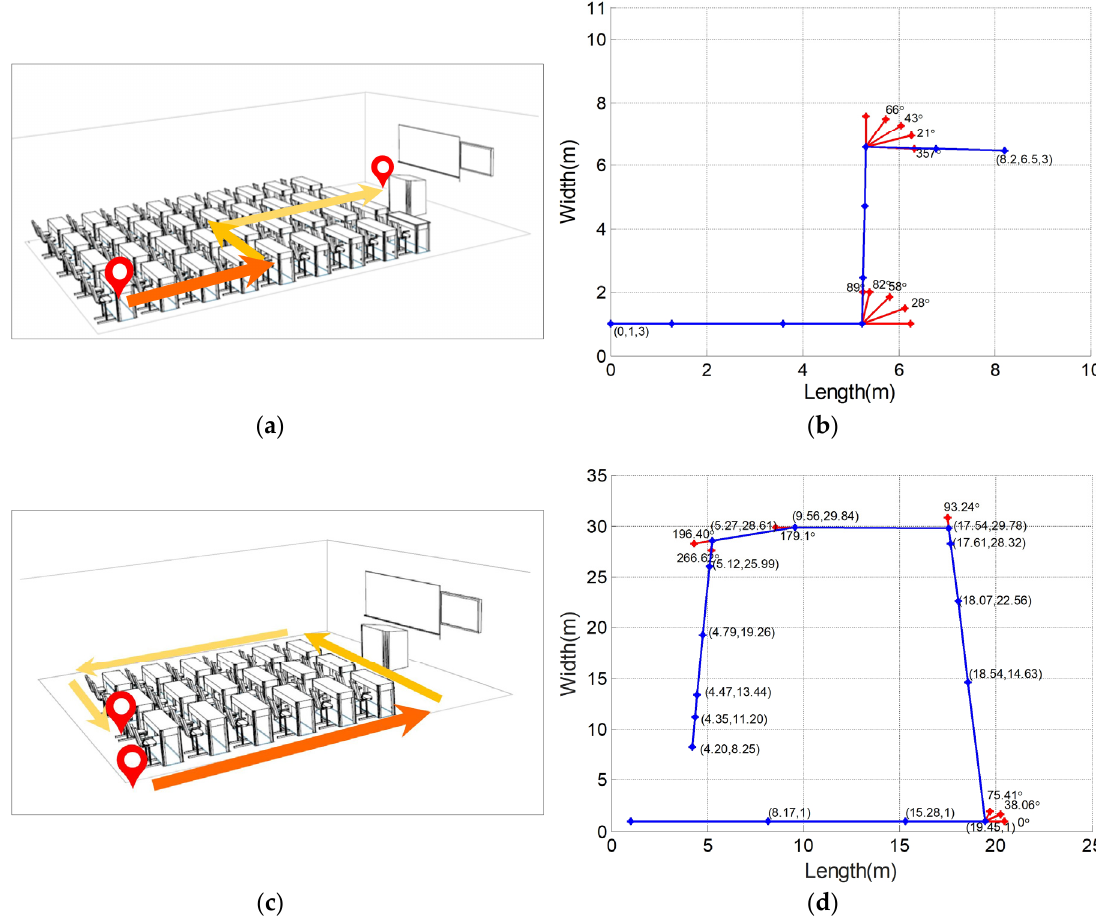
Figure 11. Comparison of the calculated route and the pre ‐ defined route. ( a ) The pre ‐ defined “Z” shaped route; ( b ) the calculated route of “Z” shaped test; ( c ) the pre ‐ defined square route; ( d ) the calculated route of square shaped test.